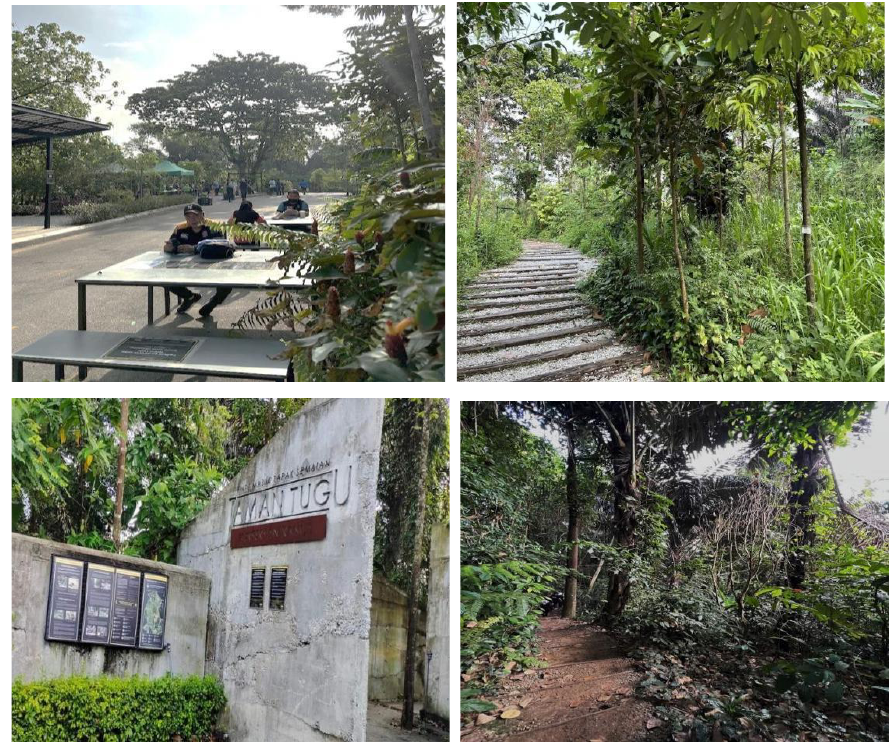
Figure 2. Photos of Taman Tugu ( left ), Kuala Lumpur ( Right ).